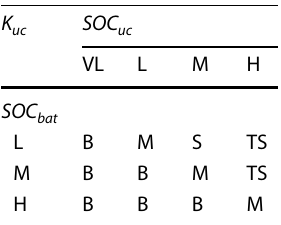
Table 4 Fuzzy rule table in charging mode( P